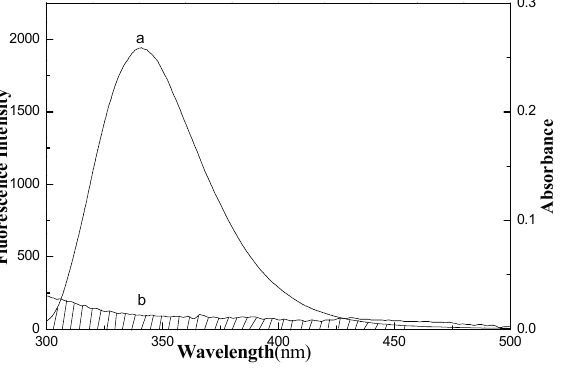
Figure 5. Overlapping between the fluorescence emission spectra of LYS (a) and UV absorption spectra of GA